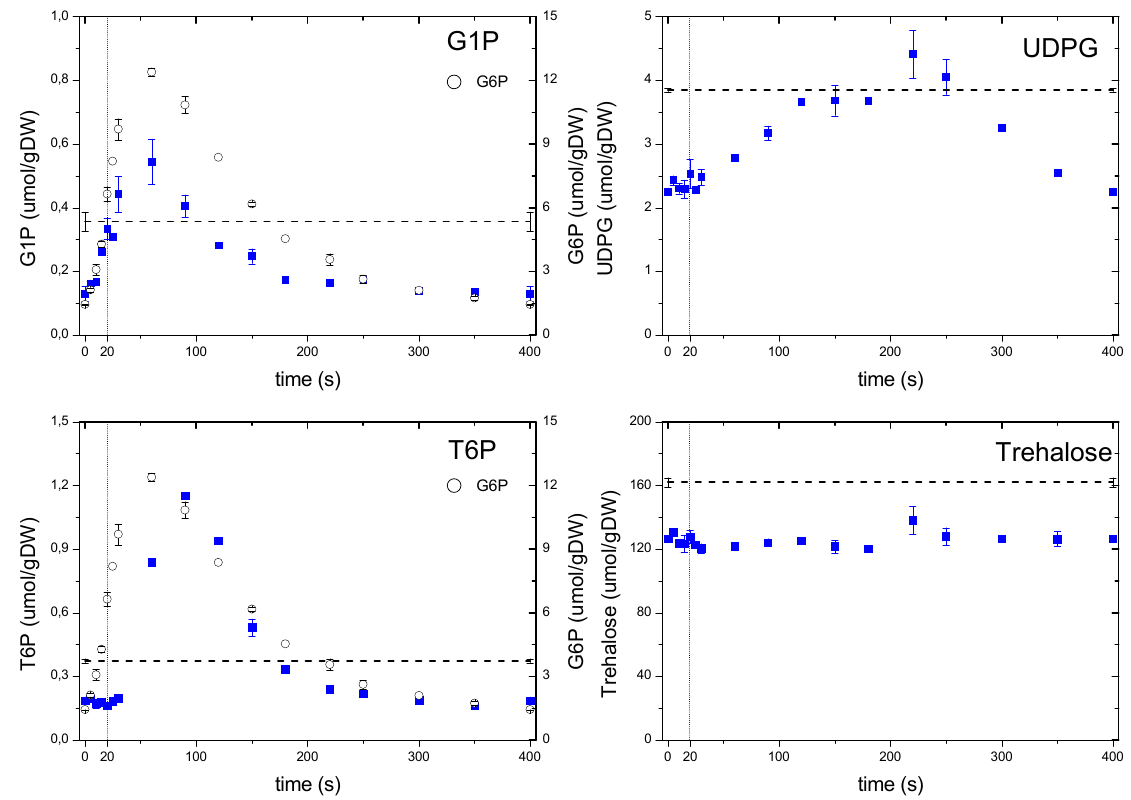
Figure 7. Concentration measurements of storage metabolites during the feast/famine cycle. The dashed line represents the reference steady-state (D = 0.1 h − 1 ), error bars represent the standard error of duplicate determination during two subsequent cycles. The vertical dotted line represents the end of the feeding